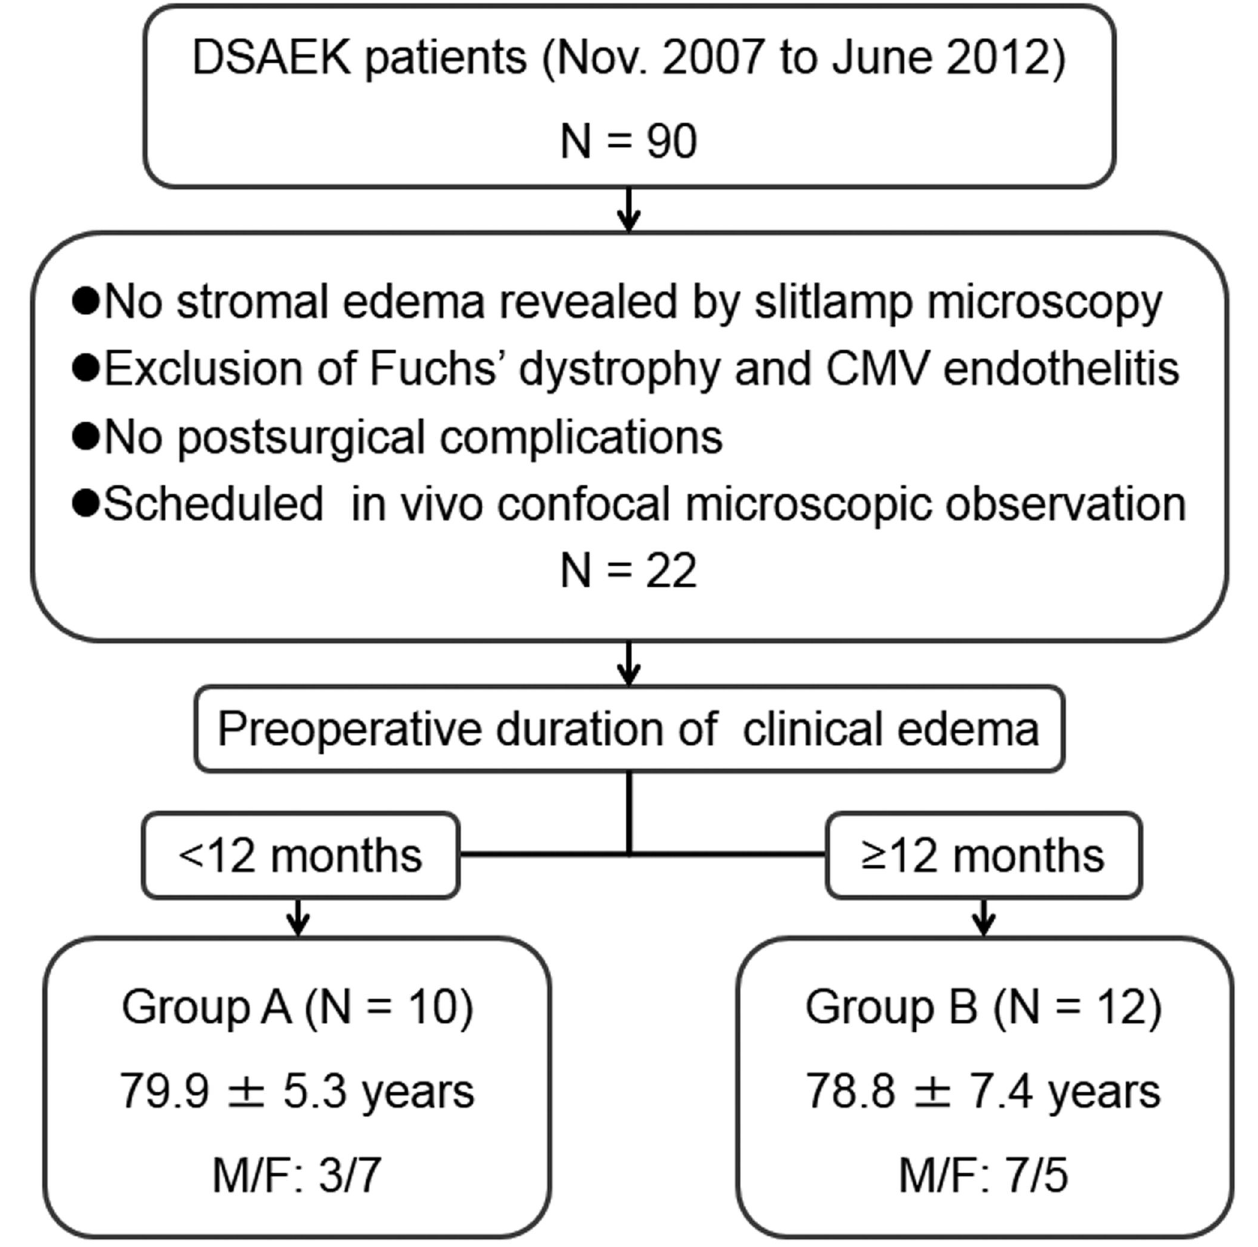
Figure 1. Flowchart for enrollment of study